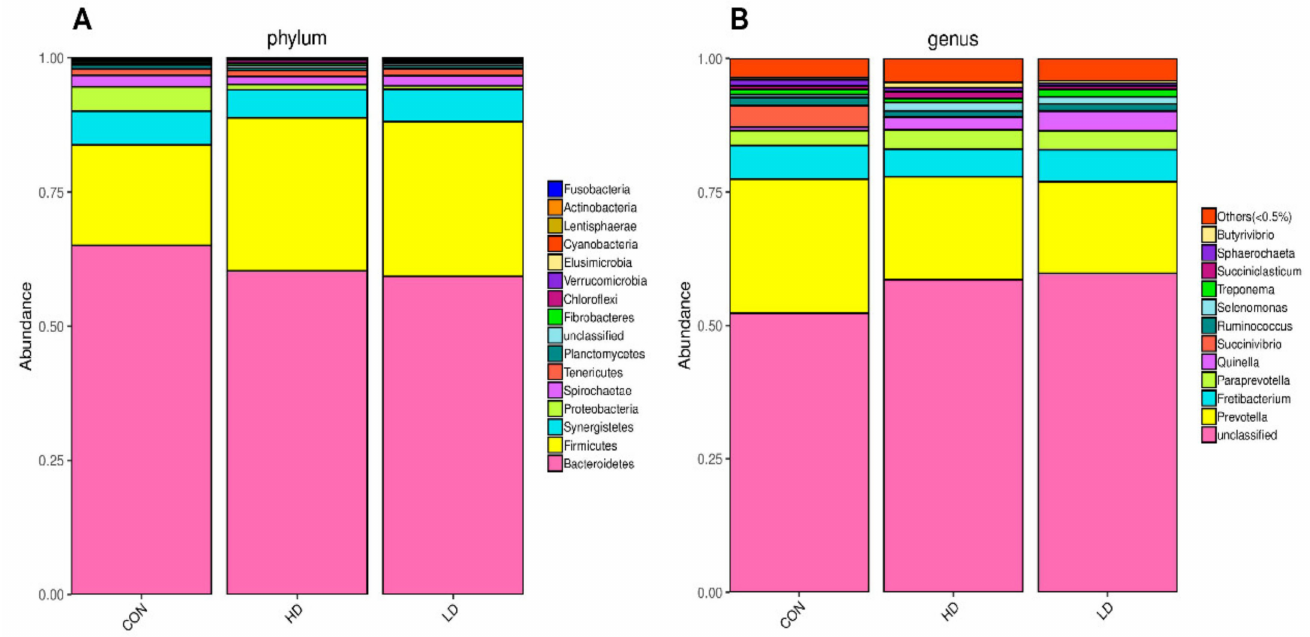
Figure 2. Rumen bacterial diversity and taxonomic classification of female goats fed varying dietary cation-anion difference. ( A ) Distributions of rumen microbiota at phylum level. ( B ) Distributions of rumen microbiota at genus level.